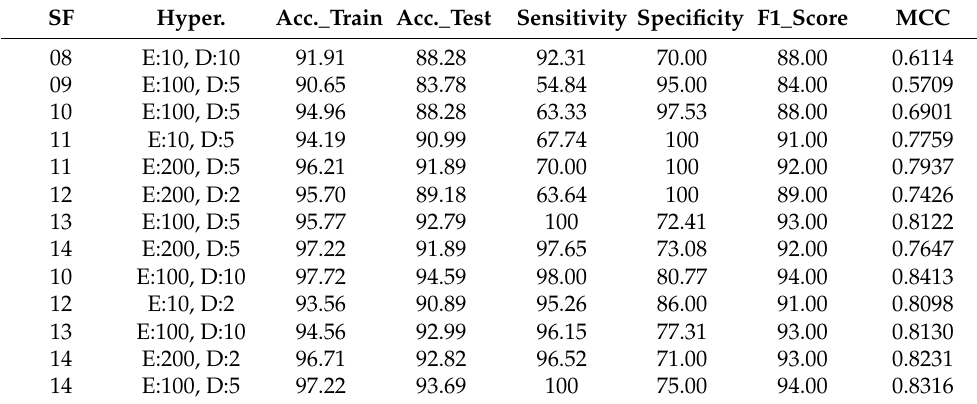
Table 4. Performance of the RF model along with χ 2 feature selection method.